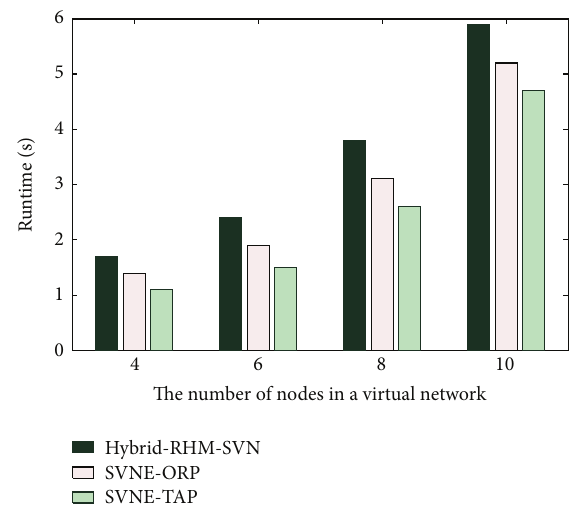
Figure 4: Runtime of mapping single virtual network.